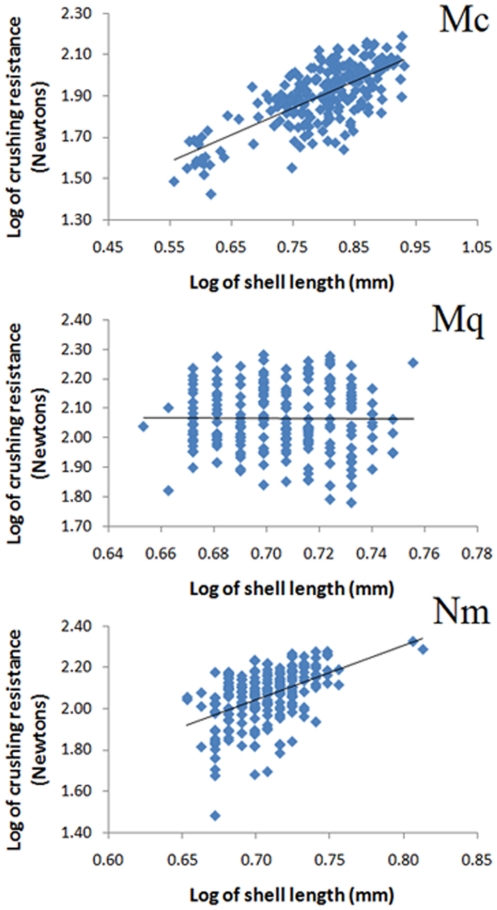
Relationship between shell length and crushing resistance (both log transformed) in Mexipyrgus churinceanus (Mc), Mexithauma quadripaludium (Mq), and Nymphophilus minckleyi (Nm).The best linear fit is shown for illustrative purposes (solid black line).